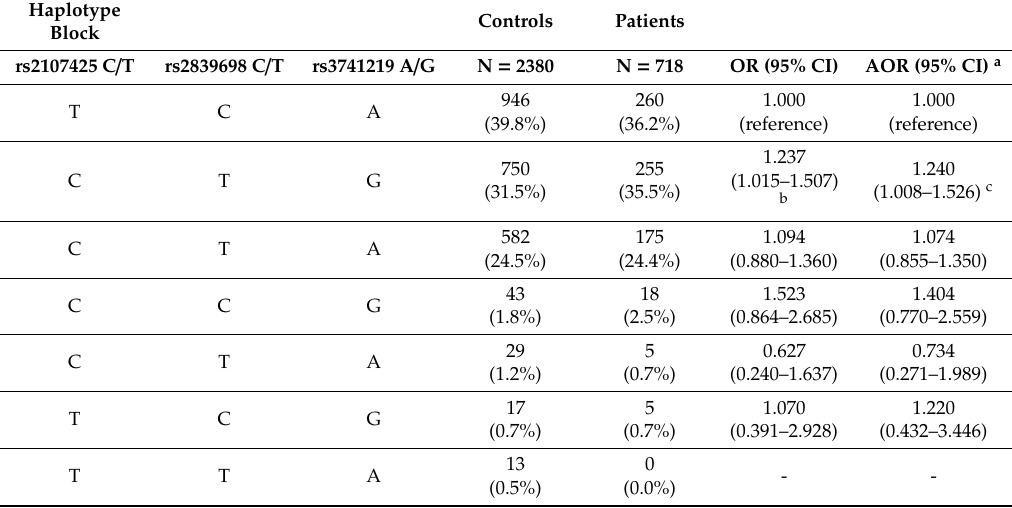
Figure 2. Prediction of potential binding between H19 and its interacting microRNAs. The structure exhibits hybridization between miR-106a and H19 with rs3741219 allele T ( a ) or C ( b ), as well as between miR-141 and H19 with rs217727 allele C ( c ) or T ( d ). The positions of exonic SNPs are indicated by blue arrows. mfe, minimum free energy. Table 5. Frequency of H19 haplotypes in HCC patients and control